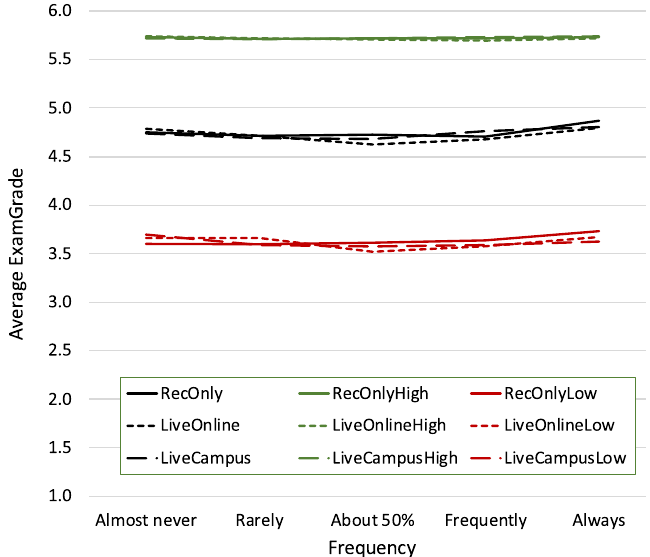
Fig. 2 Average grade on exams ( ExamGrade ) versus frequency of attendance on campus ( LiveCampus ), attendance online ( LiveOnline ), and only watching the recordings ( RecOnly ). Shown in black are the average exam grades for all students, shown in green and red are the performances of the upper and lower quartile,